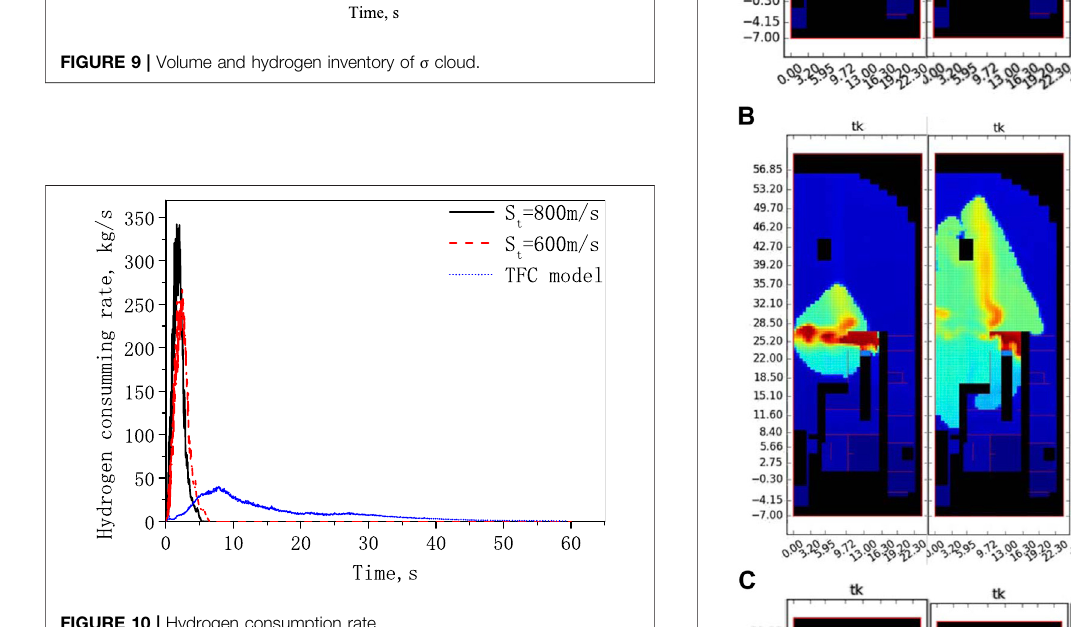
FIGURE 10 | Hydrogen consumption rate.